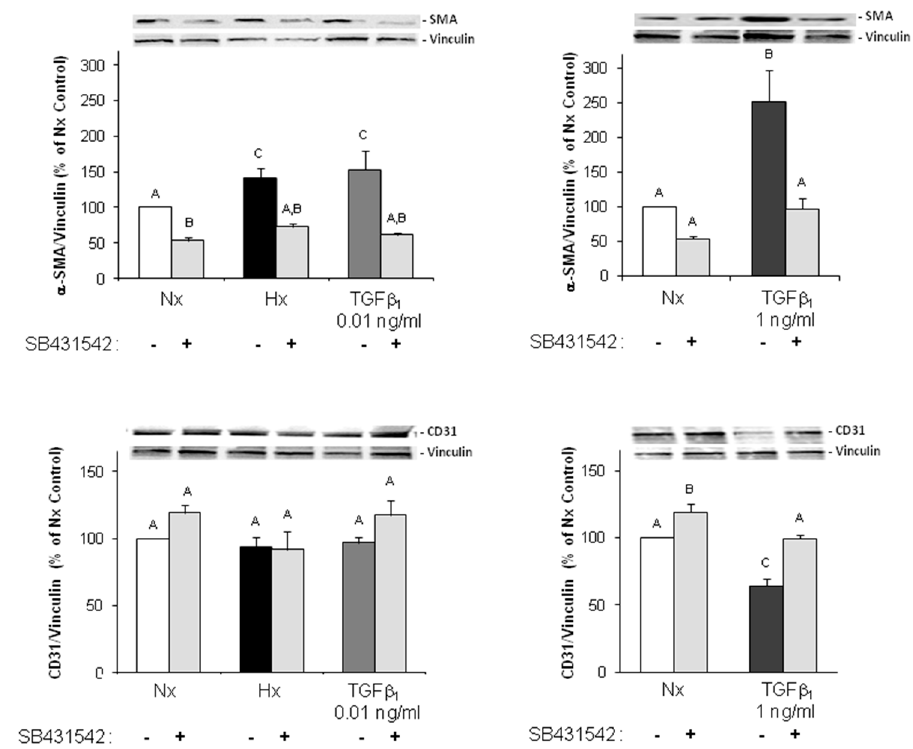
Figure 5. Hypoxia and TGF β 1 enhance α -SMA expression via SMAD2-signaling in MVECs. Endothelial cells were exposed to three days normoxia (Nx), hypoxia (Hx) or TGF β 1 in presence or absence of the ALK5 inhibitor SB431542 (1 µM). Then Western blots were performed using antibodies against α -SMA, CD31, and vinculin as loading control. Representative Western blots, and quantification of protein expression are depicted. For quantification, α -SMA/vinculin or CD31/vinculin ratios are expressed as percent increase relative to untreated normoxic controls, and are means ± SE of n = 8 independent culture preparations. Uppercase letters indicate significant differences between groups with p ≤ 0.05.